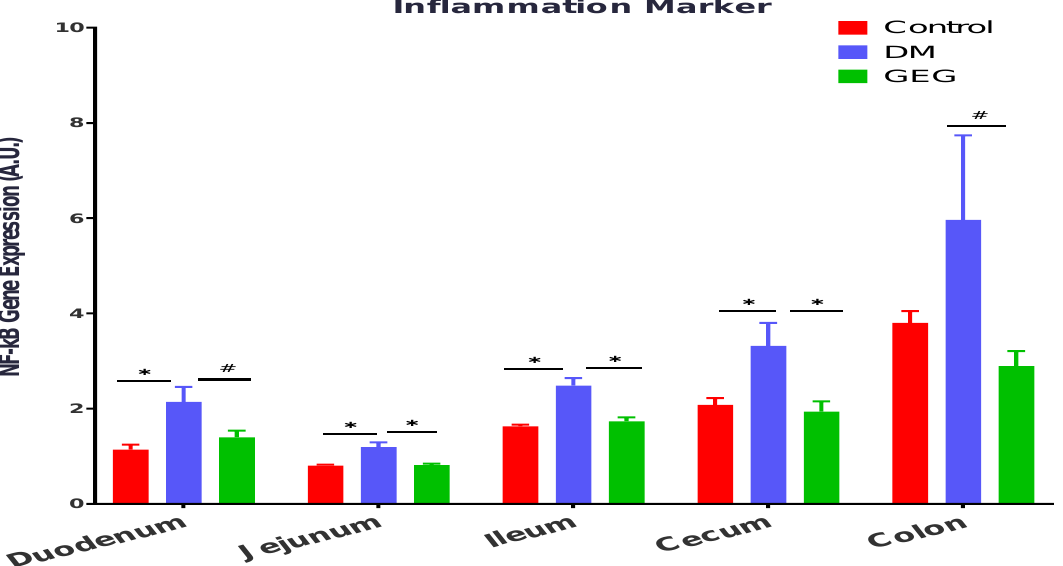
Figure 14. Effect of gingerol-enriched ginger (GEG) on mRNA gene expression of NF-kB in duode- num, jejunum, ileum, cecum, and colon of rats. Data is expressed as mean ± SEM. n = 6 – 8 per group. Data was analyzed by one-way ANOVA followed by a post hoc Tukey’s test. * p < 0.05. # 0.05 < p <